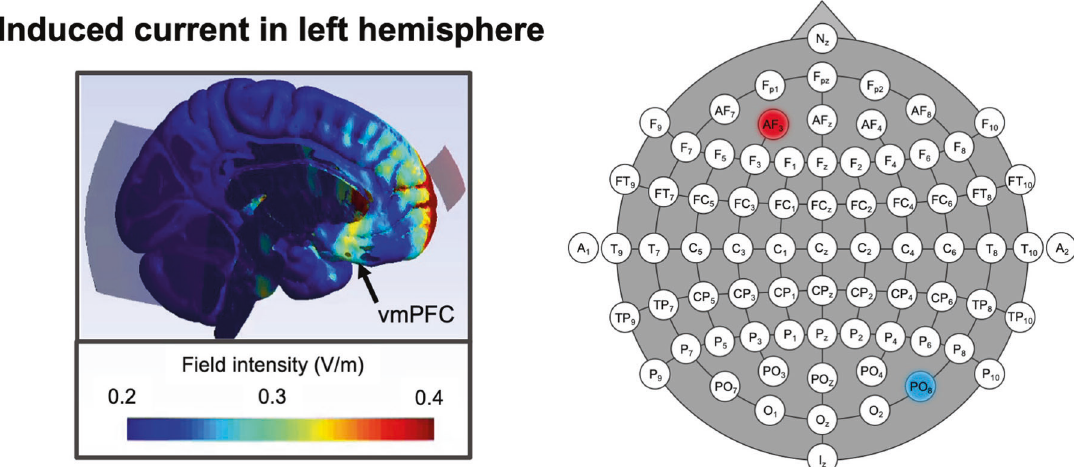
Fig. 2 Biophysical modeling of the current ’ s distribution and magnitude induced by anodal tDCS applying a 3 × 3 cm² anode over AF 3 and a 10 × 10 cm² cathode over PO 8 . The left panel depicts changes in electrical fi eld intensity (V/m) when tDCS is applied in the described montage, while the right panel depicts the according location of the anode (red) and cathode (blue) according to the 10 – 20 EEG system (see “ Methods ” for details on biophysical